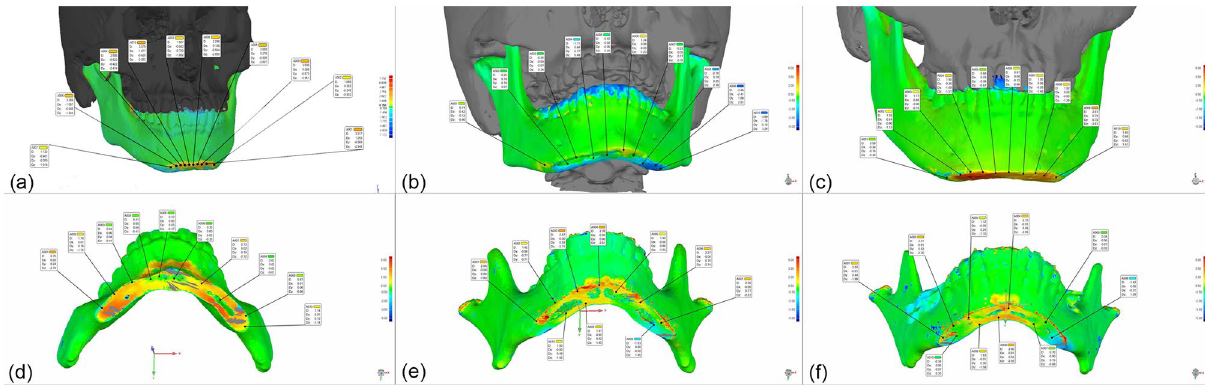
Figure 6. Accuracy analysis of genioplasty for all